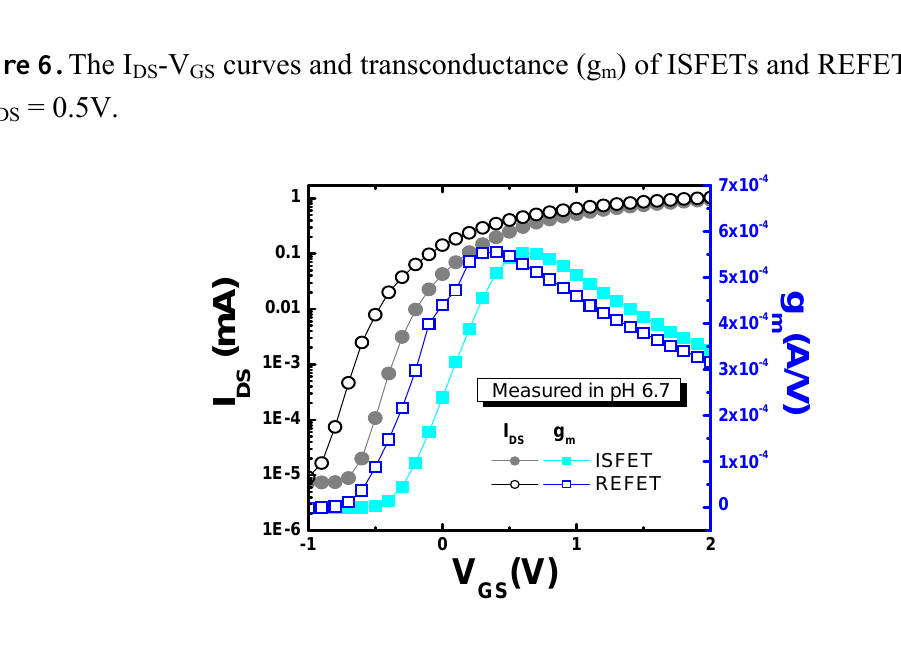
) of ISFETs and REFETs measured m